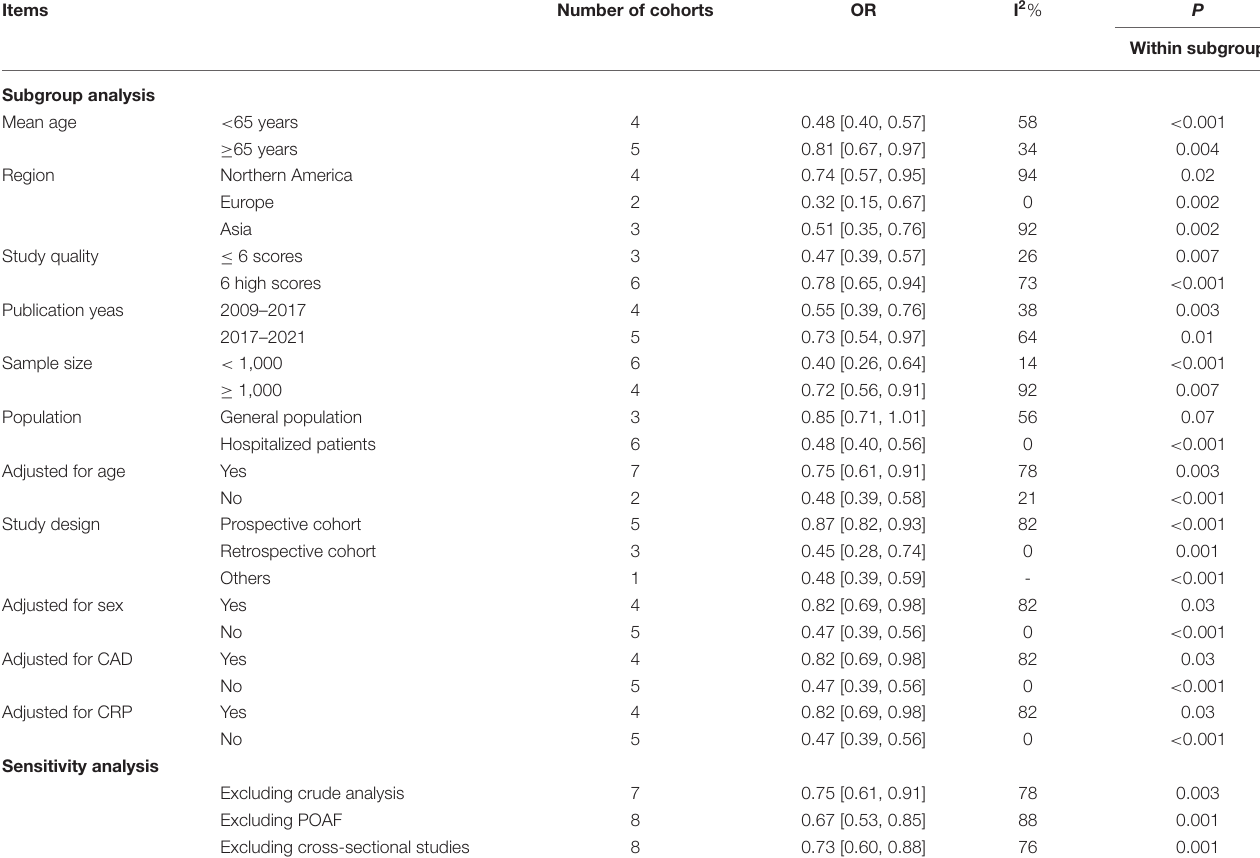
TABLE 2 | Subgroup analysis and sensitive analysis of serum albumin and risk of atrial fibrillation. Items